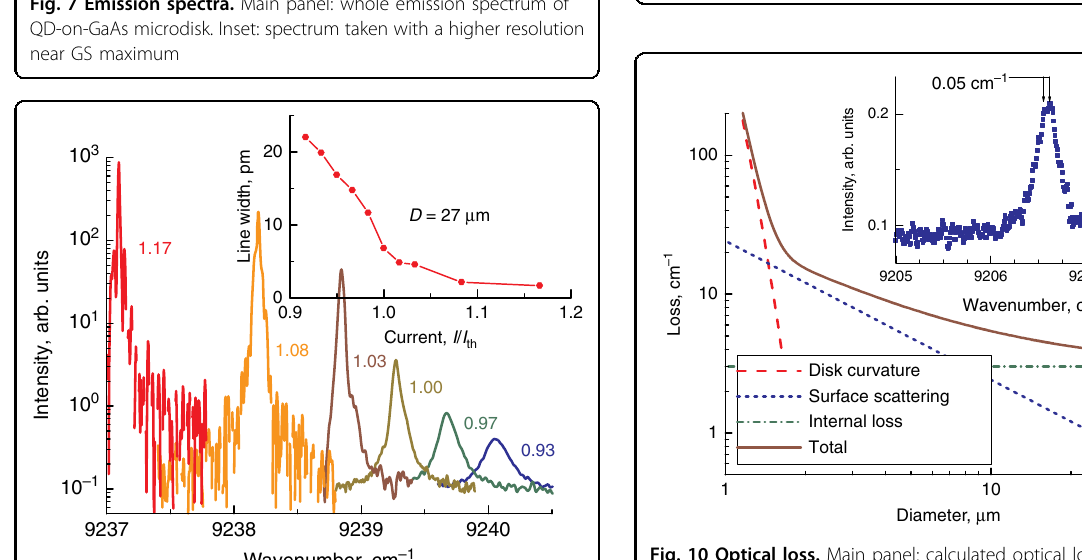
Fig. 9 Mode wavelength and intensity. Spectral position (open symbols) and line intensity (solid symbols) of three brightest WGMs of QD-on-GaAs microdisk as a function of injection current